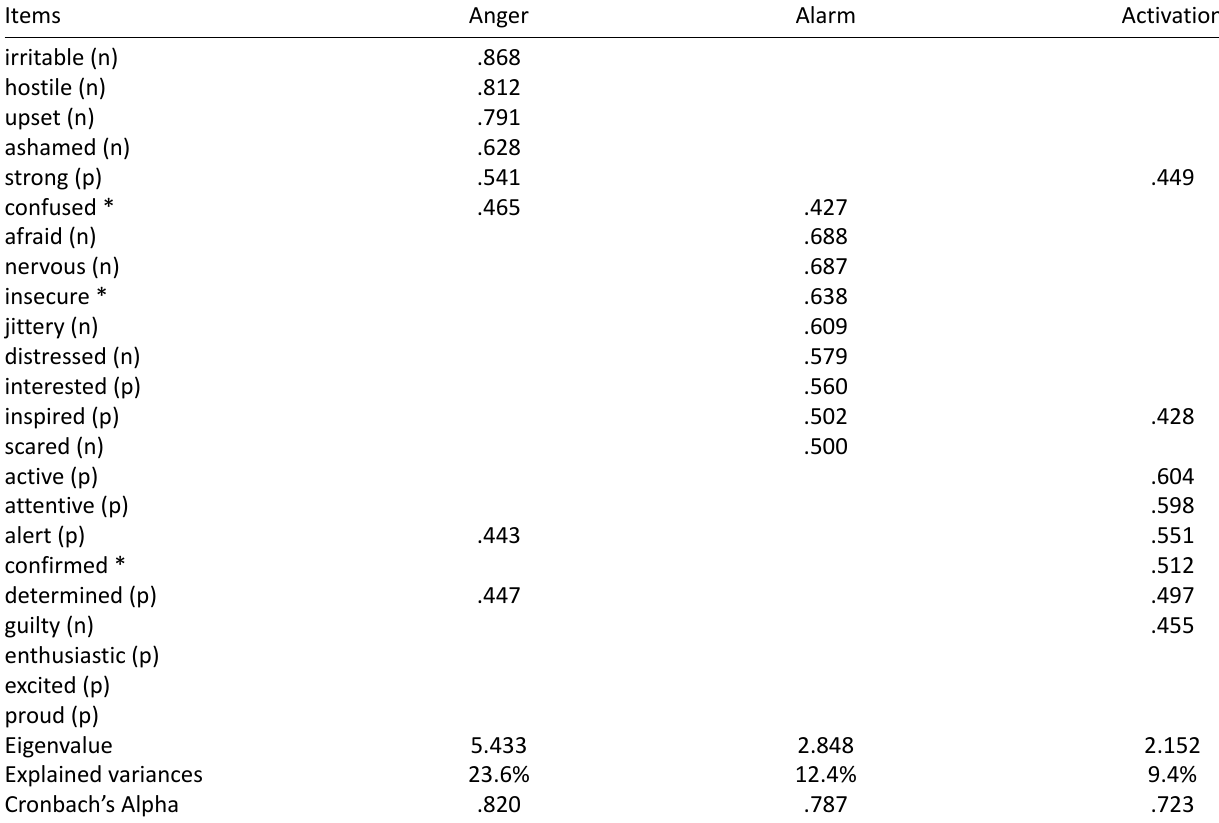
Table 1. PCA of affect items.